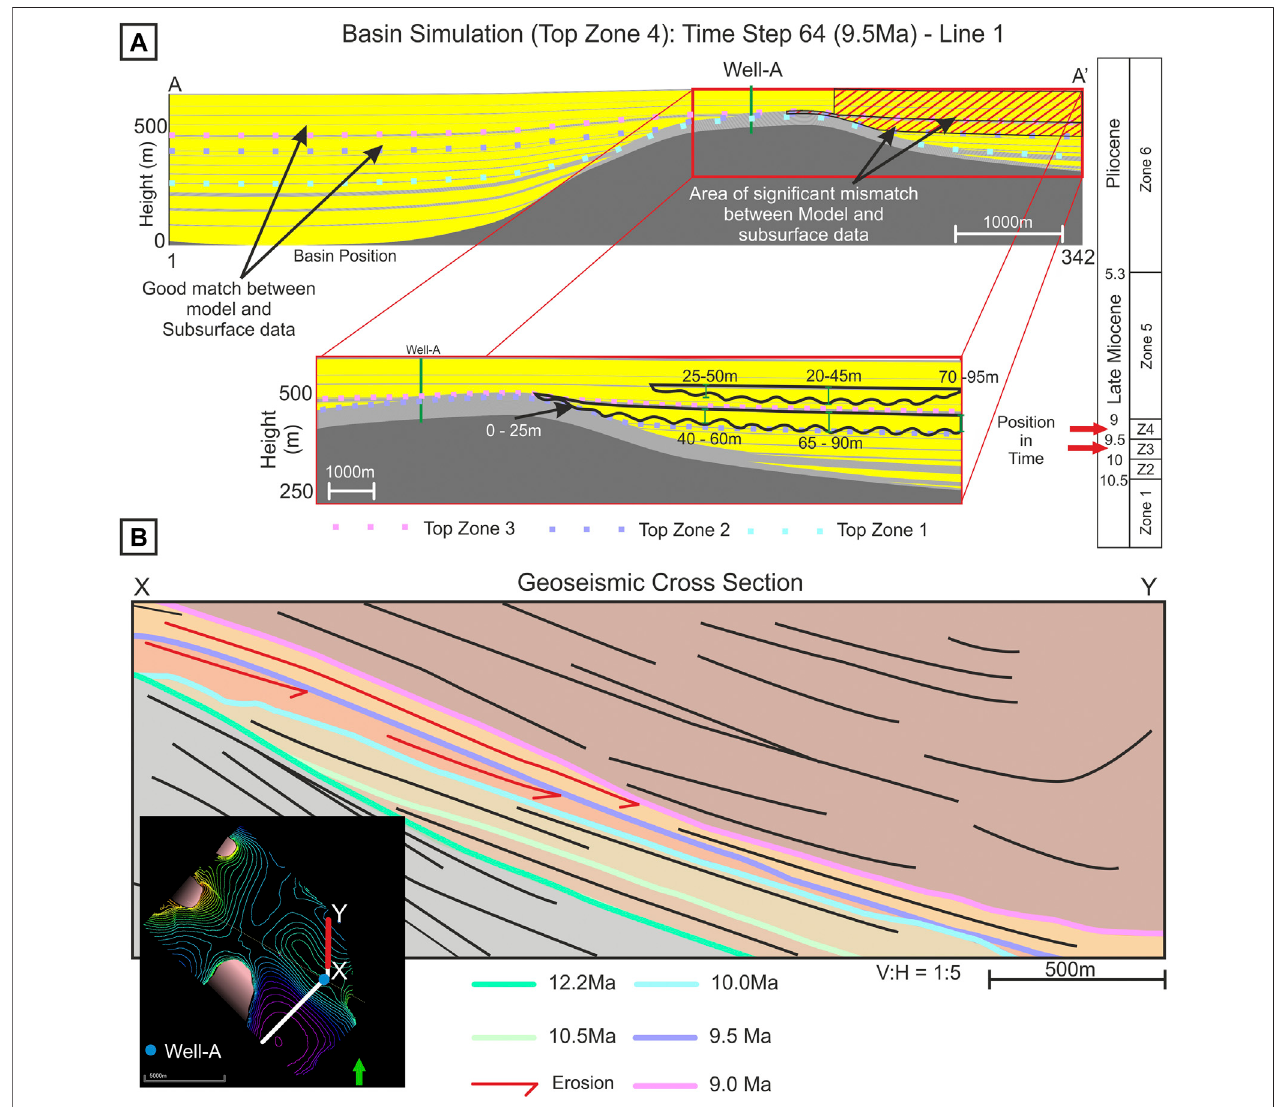
FIGURE 14 | (A) Basin simulation of Top Zone 4 of Line 1. A good match was achieved between the Onlapse-2D model and subsurface data in Zone – 3 & 4 in Minibasin-1 and High-1. Red hashes show in Minibasin 2 where for Zone 3 & 4 a signi fi cant mismatch occurred. Insert shows what Onlapse-2D simulated to develop, within Zone 3, an increasing amount of over-thickening is shown, and while for Zone 4 the over-thickening is more constrained to the centre of Minibasin 2. (B) Geoseismic cross section focused on Minibasin-2. Map insert shows location where geoseismic is taken from. Red arrows highlight that between 10.0 – 9.5 Ma & 9.5 – 9.0 Ma, seismic re fl ectors are eroded into by major horizons.This provides evidence that the mismatch between simulation and subsurface data occurs because there has been erosion within Minibasin